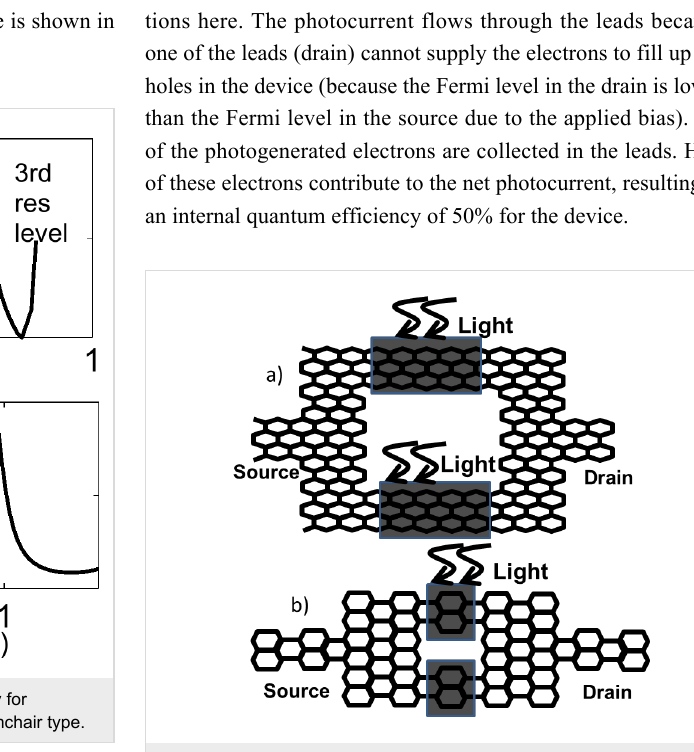
The results of the interaction of light with the zigzag